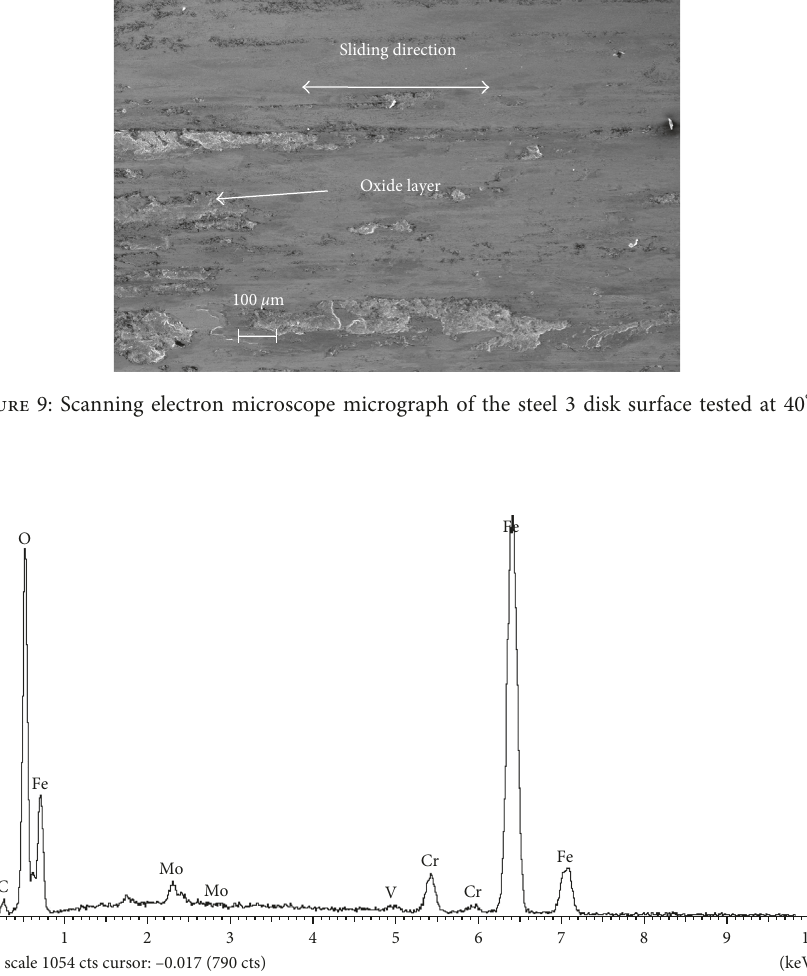
Figure 10: EDS spectrum of the oxides in Figure